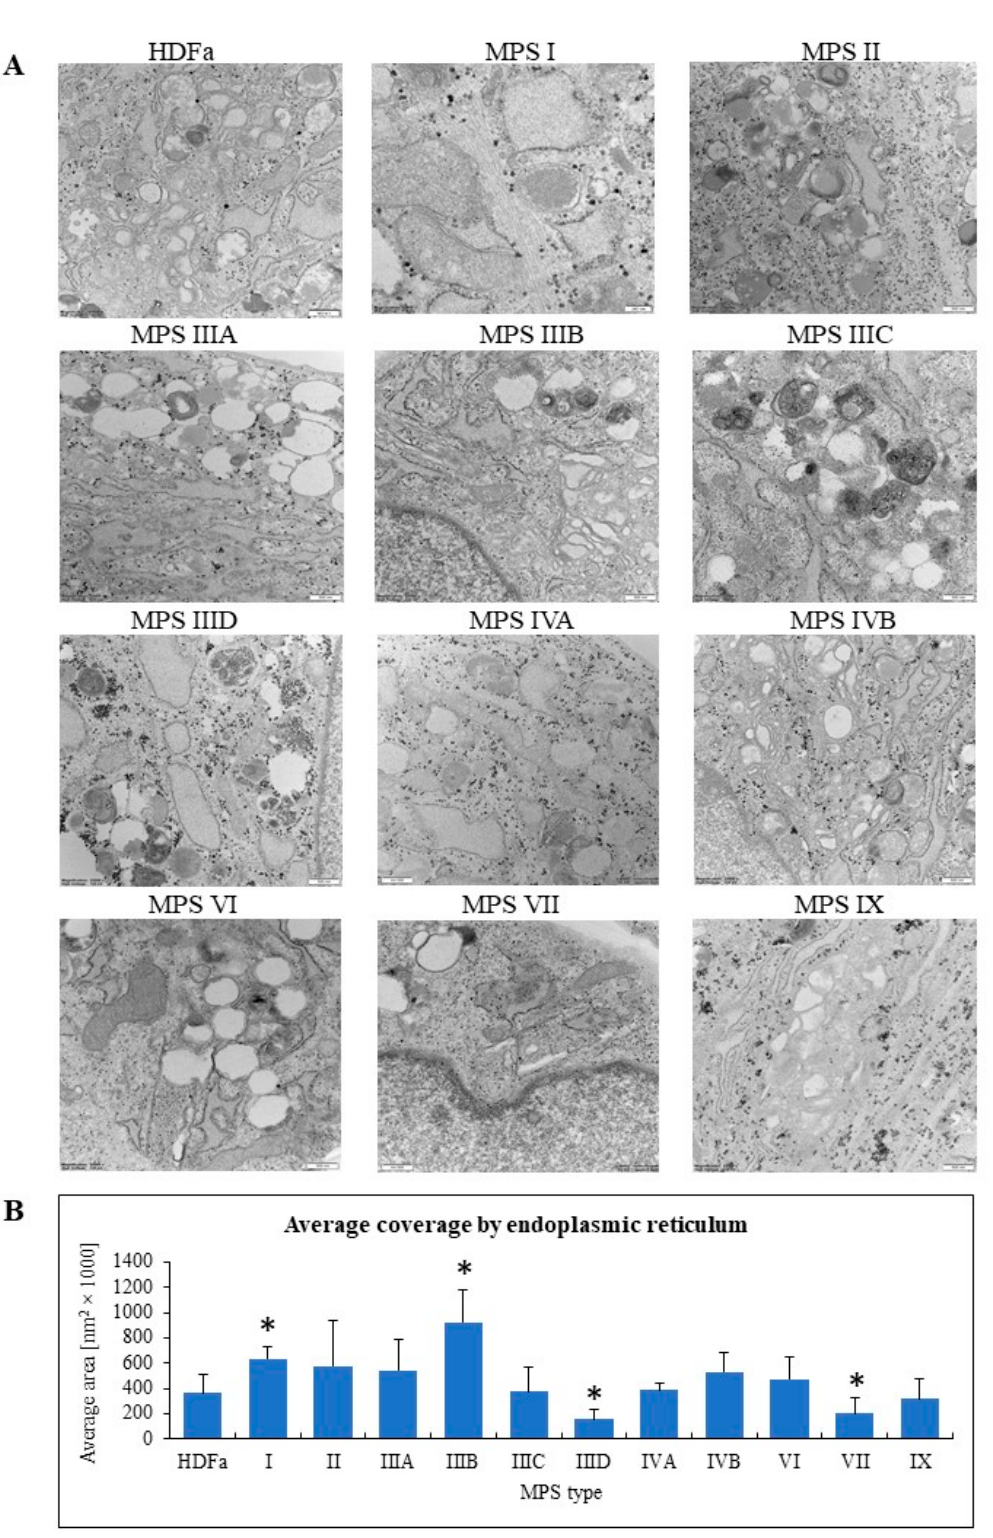
Figure 9. Morphology of endoplasmic reticulum in MPS fibroblasts in comparison to control cells (HDFa cell line). Representative electron micrographs are presented in ( A ) (size bars represent 500 nm). Quantification of changes in endoplasmic reticulum is presented in ( B ). Mean values ± SD are presented, with asterisks representing statistically significant ( p < 0.05) differences relative to the HDFa control.